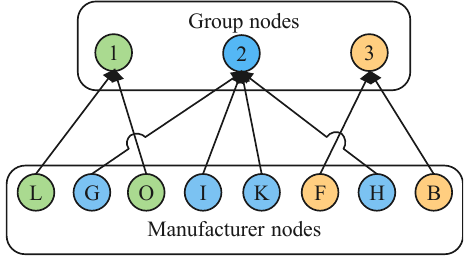
Figure 4. Bipartite network.